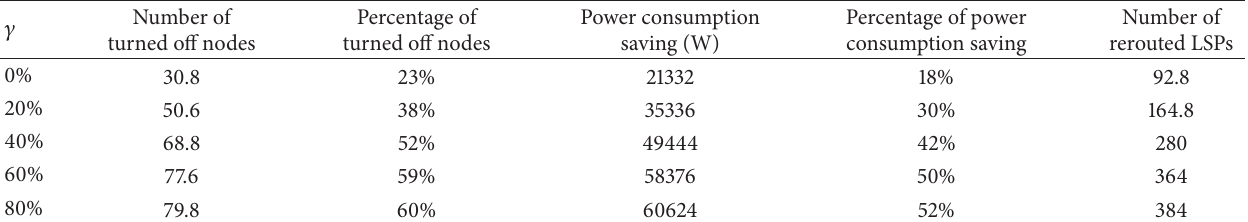
Table 2: Number and percentage of switched off nodes, power consumption saving and relative percentage, and number of LSPs rerouted are reported for the EBONE network in the case of traffic reduction 𝛾 from 0 to 80%.